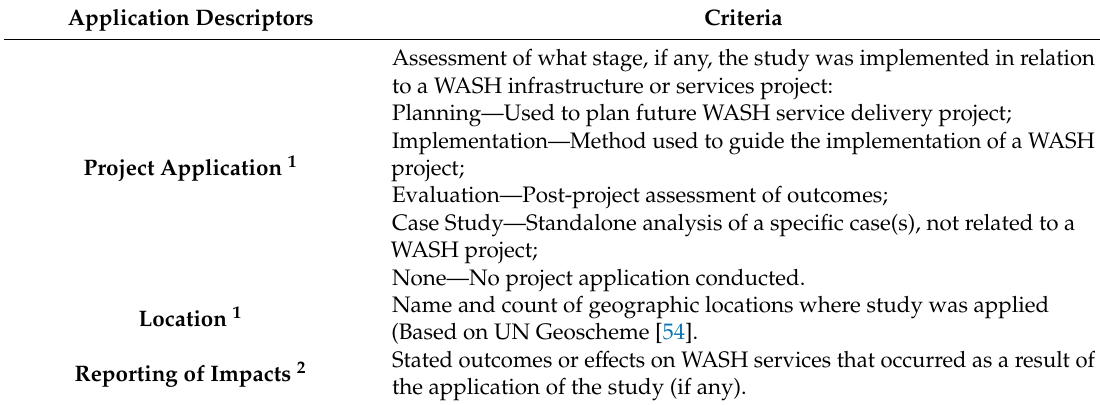
Table 3. Descriptors and criteria for assessing the application